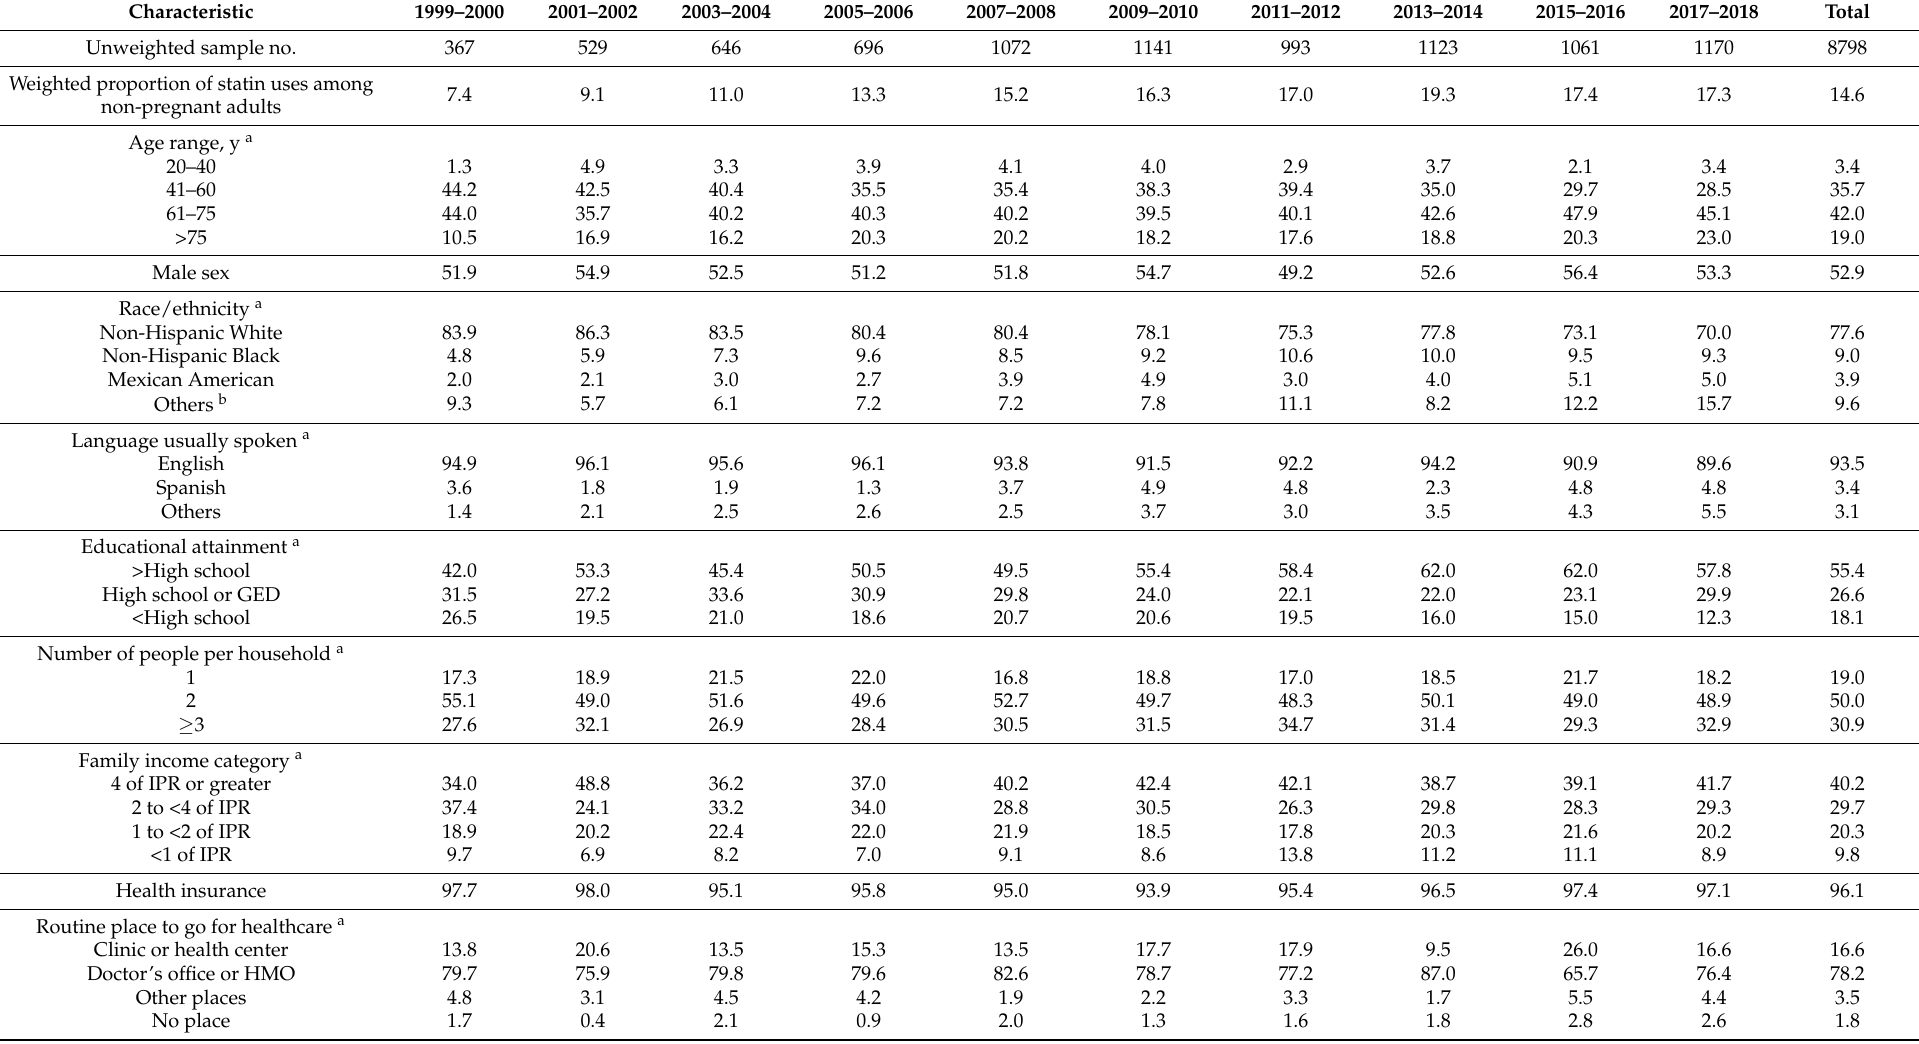
Table 1. Characteristics of the study sample by survey cycle for